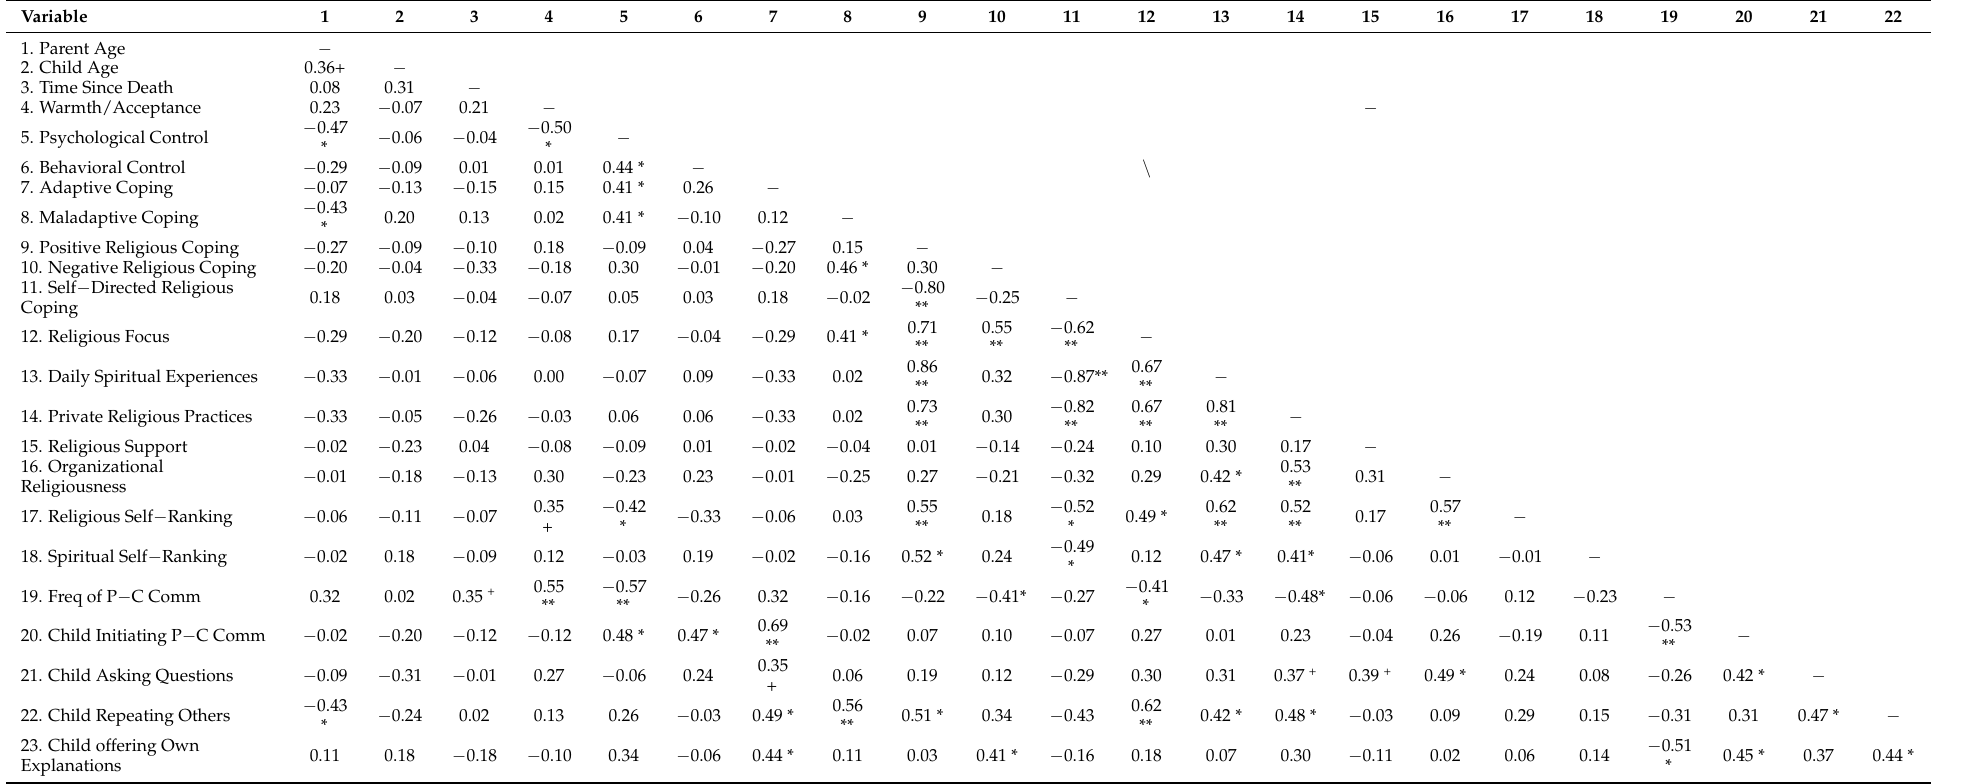
Table 4. Intercorrelations among demographics, parenting dimensions, coping, religiosity, and frequency of parent − child communication about